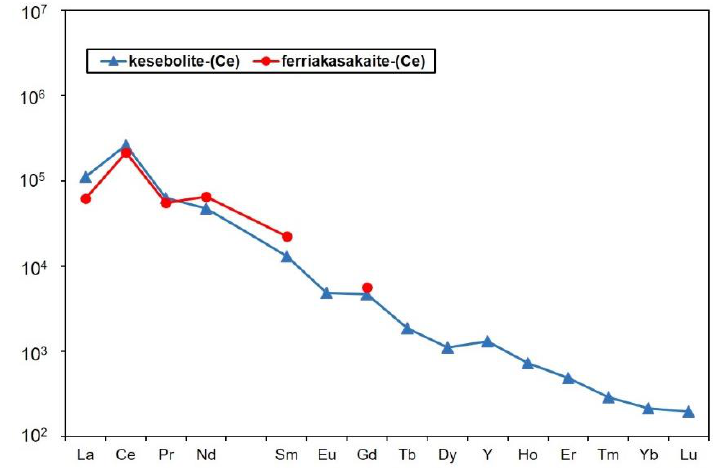
Figure 7. Chondrite-normalized REE pattern for kesebolite-(Ce) compared with ferriakasakaite-(Ce) based on ICP-MS analyses. Chemical data for ferriakasakaite-(Ce) from Kesebol (EPMA-WDS data) are taken from [10].